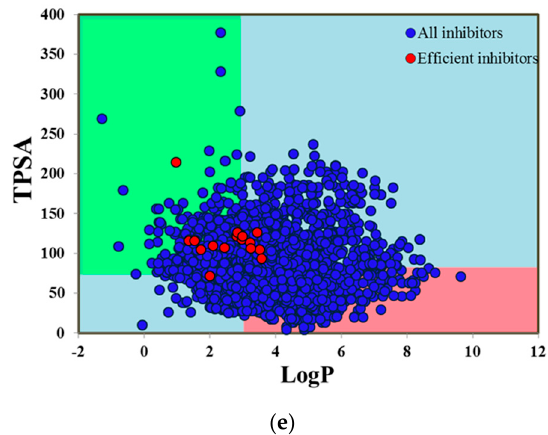
Figure 8. Pfizer 3 / 75 rule positioning of ( a ) CYP1A2 inhibitors, ( b ) CYP2C9 inhibitors, ( c ) CYP2C19 inhibitors, ( d ) CYP2D6 inhibitors and ( e ) CYP3A4 inhibitors. Here, all compounds are denoted by blue points and highly efficient inhibitors of CYP isoforms are shown by red points. The compounds located in the pink square show a greater likelihood to cause toxicity and experimental promiscuity.